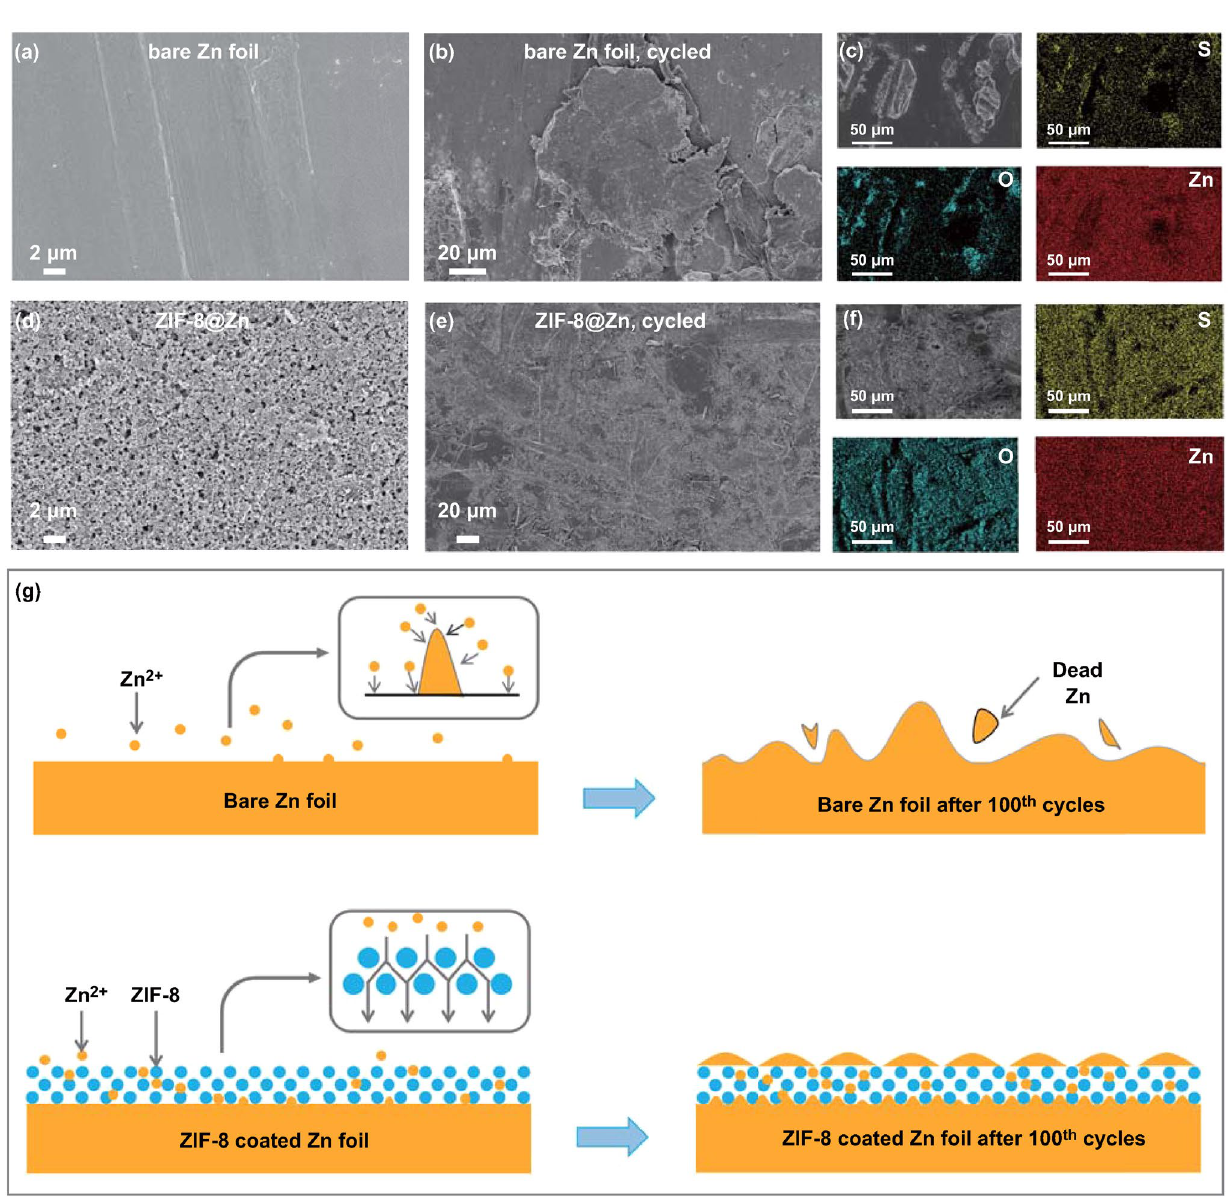
Fig. 6 SEM images and EDS mapping of bare Zn electrode a before and b , c after 100 stripping/plating cycles, ZIF‑8@Zn electrode d before, and e , f after 100 stripping/plating cycles. g Schematic illustration for morphology change of the bare Zn foil and ZIF‑8@Zn electrodes during repeated Zn stripping/plating